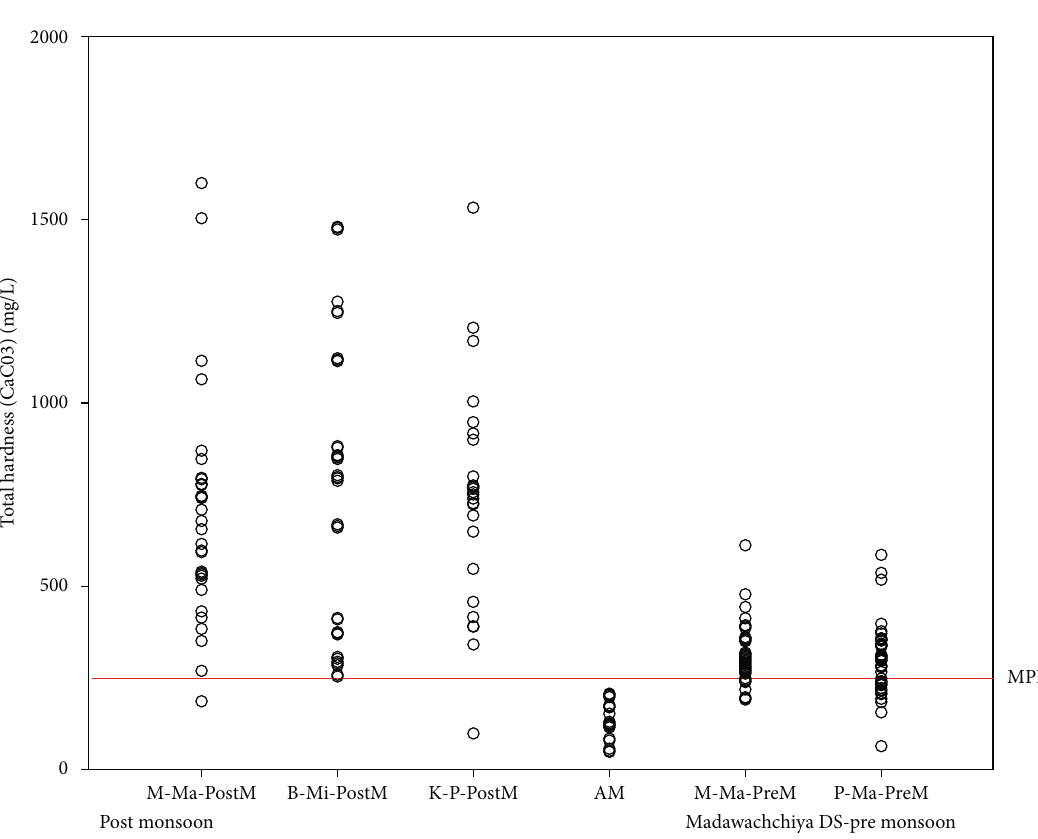
Figure 2: Hardness content of well water samples in study